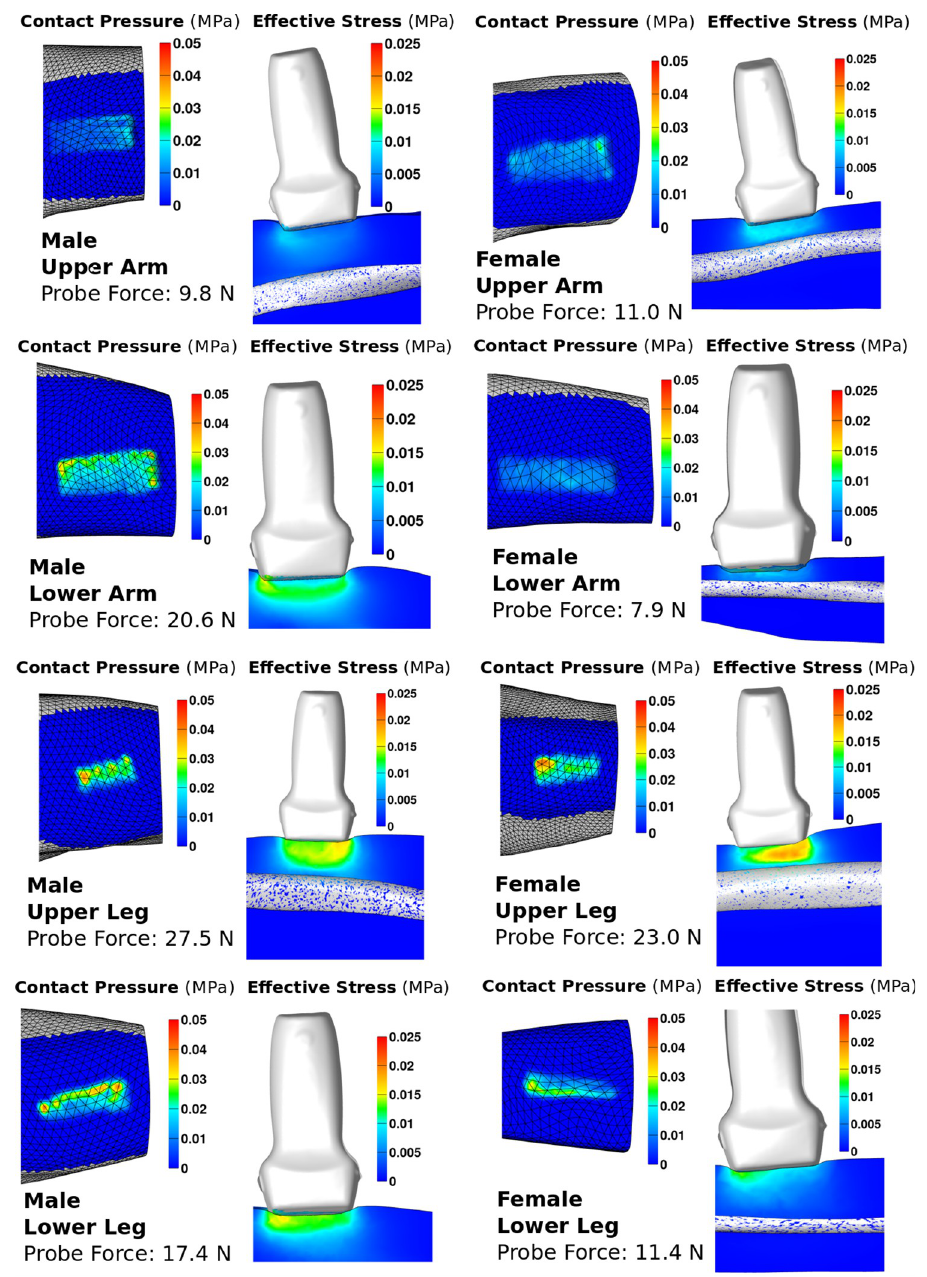
Fig 6. Effective stress and contact pressure for all eight models after calibration, at maximum probe indentation. Note that displacements and reaction forces extend past experimental conditions. This is because the end point of simulation and experimentation do not match due to the clipping of simulation data, which occurred during the post processing of simulation data upon the completion of the simulation.